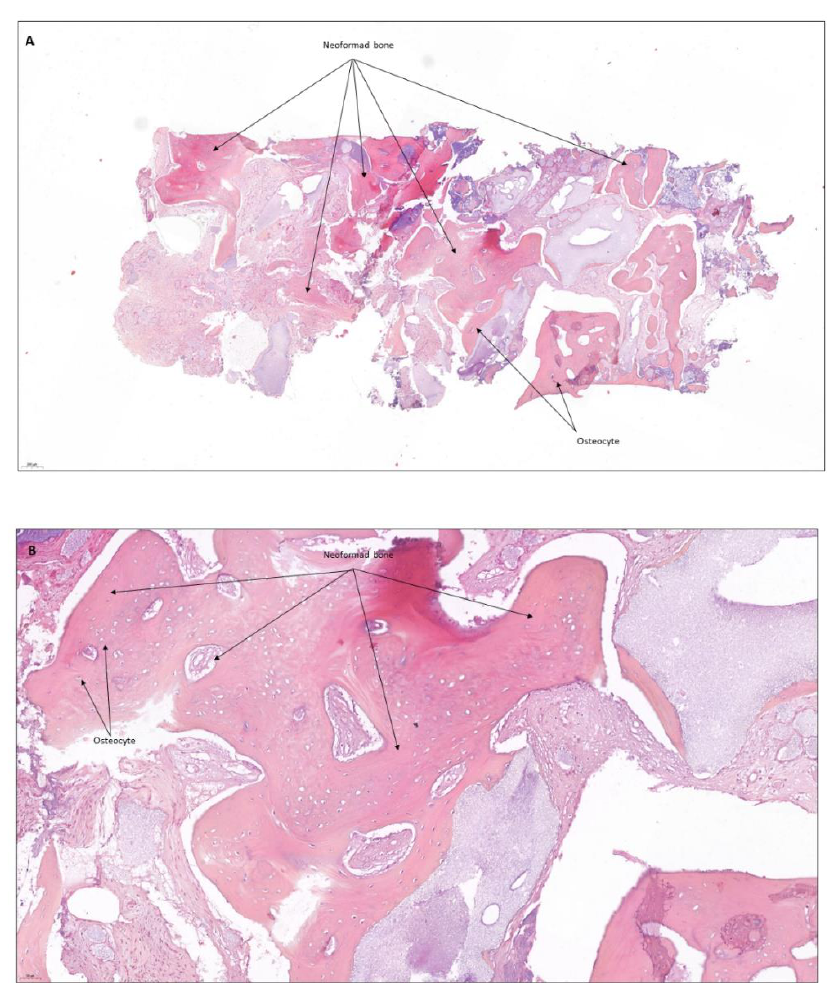
Figure 20. Abundant newly formed bone in ( A ) at 50 × and in ( B ) at 200 × . Total bone length is 7.2 mm and newly formed bone is 5.4